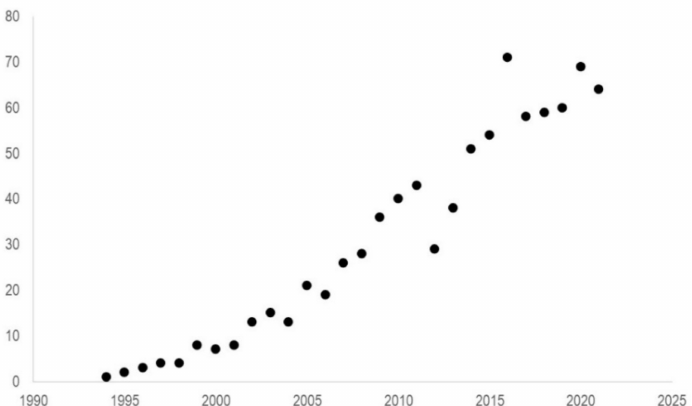
Figure 1. The number of papers (Y-axis) available in the PubMed database published in each year since 1994 (X-axis) containing the terms “Fluorodeoxyglucose” and